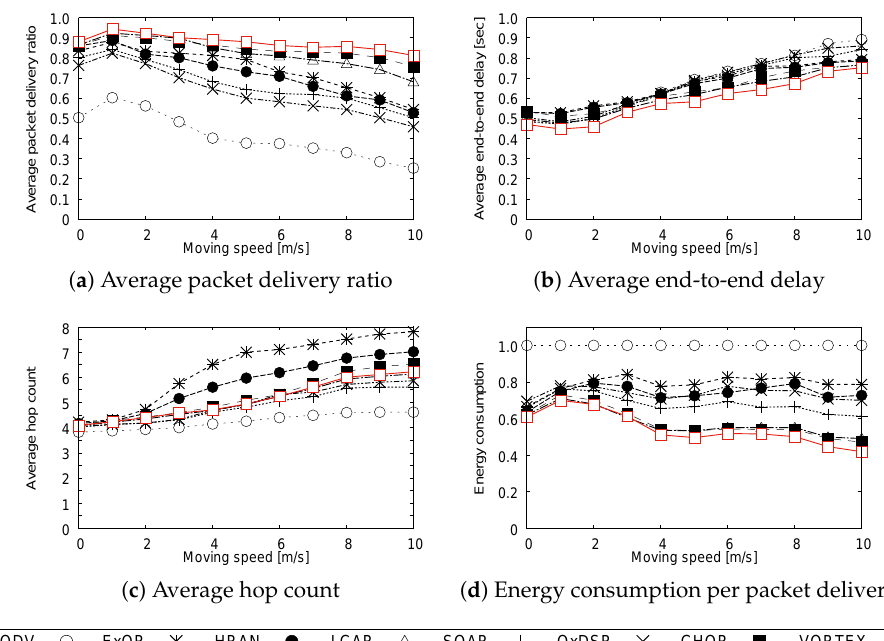
Figure 4. Results of Simulation